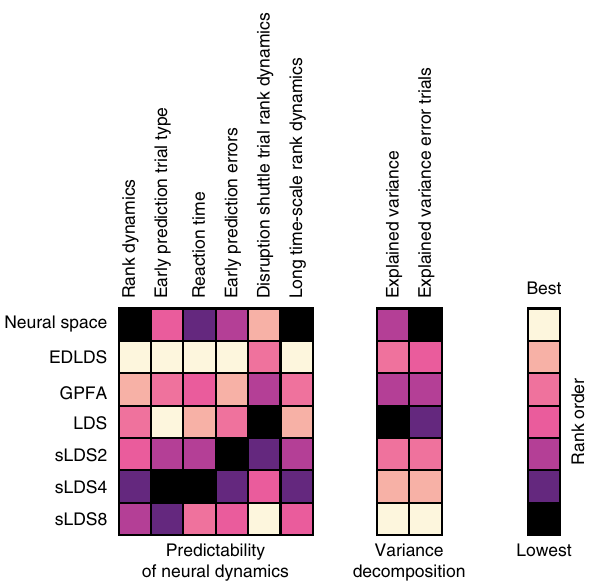
Fig. 7 Summary of comparison across models. Results from Fig. 2 to Fig. 6 were compared across models and summarized into a pairwise comparison table. The comparison is divided into two categories according to the nature of the analyses. The fi rst category emphasizes the predictability of behavioral and neural variability from different models. The analyses in this category includes: (1) rank dynamics: Fig. 4g, Supplementary Fig. 6; (2) early prediction of trial type: Fig. 3b, Supplementary Fig. 3a; (3) reaction time: Fig. 3d, Supplementary Fig. 3b; (4) early prediction of errors: Fig. 6d, Supplementary Fig. 10b; (5) disruption shuf fl e trial rank dynamics: Supplementary Fig. 7; (6) long time-scale rank dynamics: Fig. 5cd, Supplementary Fig. 8. The second category emphasizes the variance explained by each model. This includes the explained variance for correct trials (Fig. 2d) and error trials (Fig. 6b, Supplementary Fig.